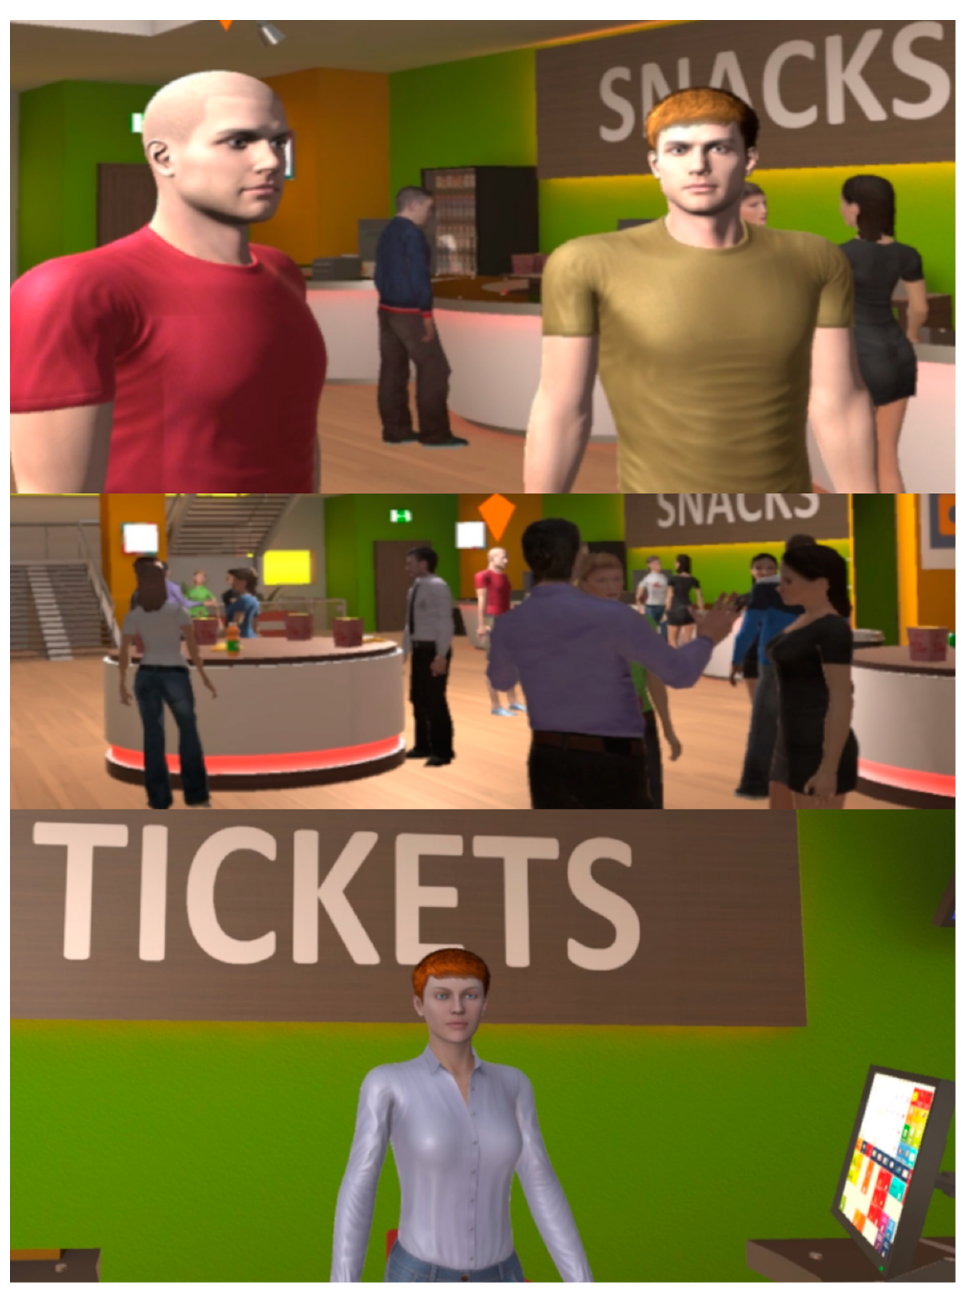
Figure 5. Friends ( Top ), main area ( Middle ), and ticket desk ( Bo tt om ) of the